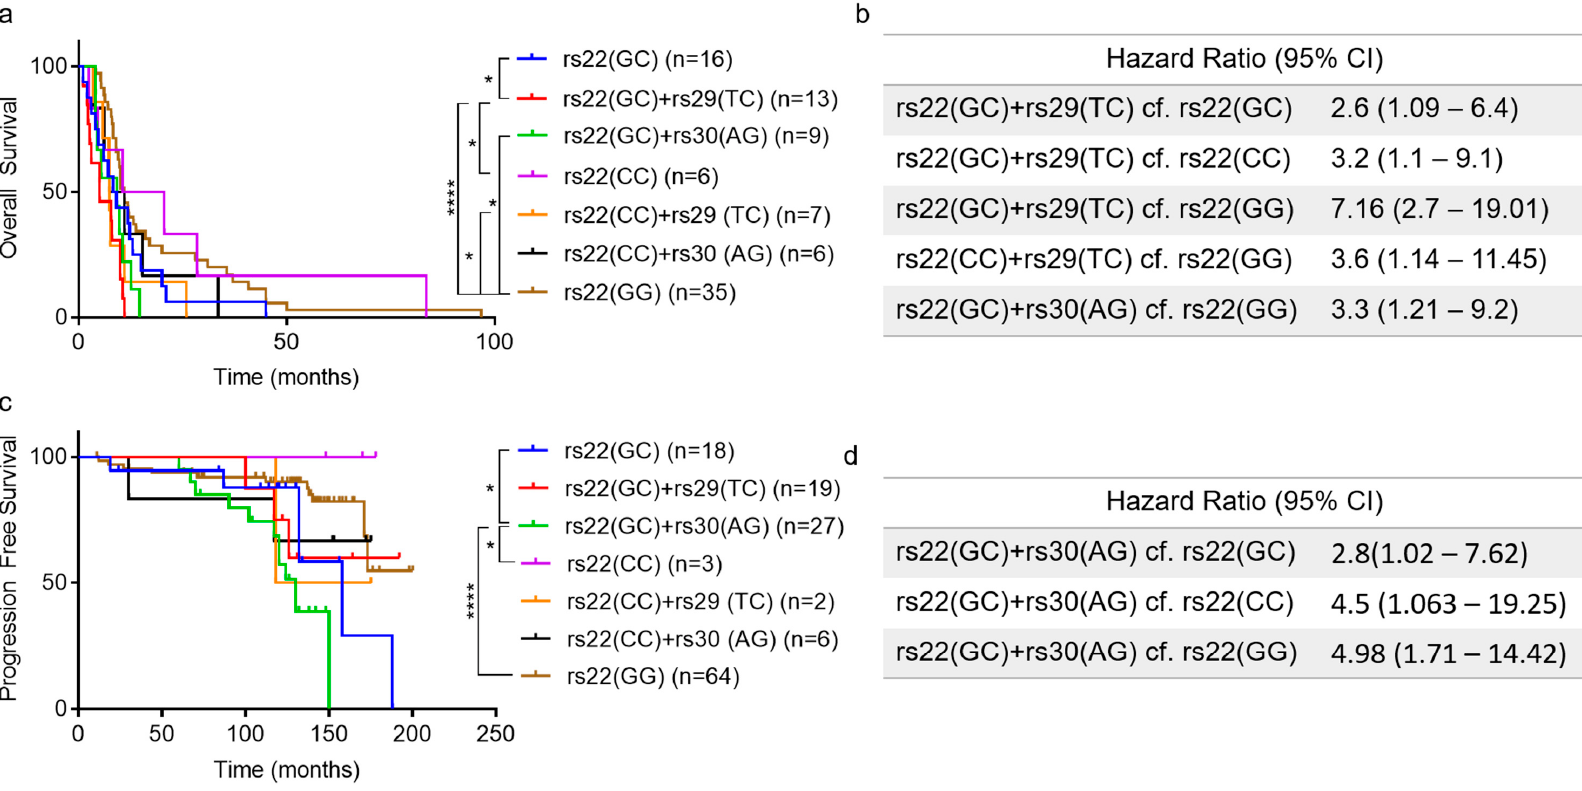
Figure 2. Intronic SNPs (rs29 and rs30) are associated with shorter survival of glioblastoma and prostate cancer patients. ( a ) Overall Survival of glioblastoma patients. ( b ) Hazard ratio (95% CI, significant p -value, <0.05) for groups with significant differences in overall survival (GBM patients). ( c ) Progression free survival of prostate cancer patients. ( d ) Hazard ratio (95% CI, significant p -value, <0.05) for groups with significant progression-free survival (PCa patients). ( a ) and ( c ). Kaplan–Meier analysis, significance determined using the log-rank test (*—significant p -value, * < 0.05, **** < 0.0001).